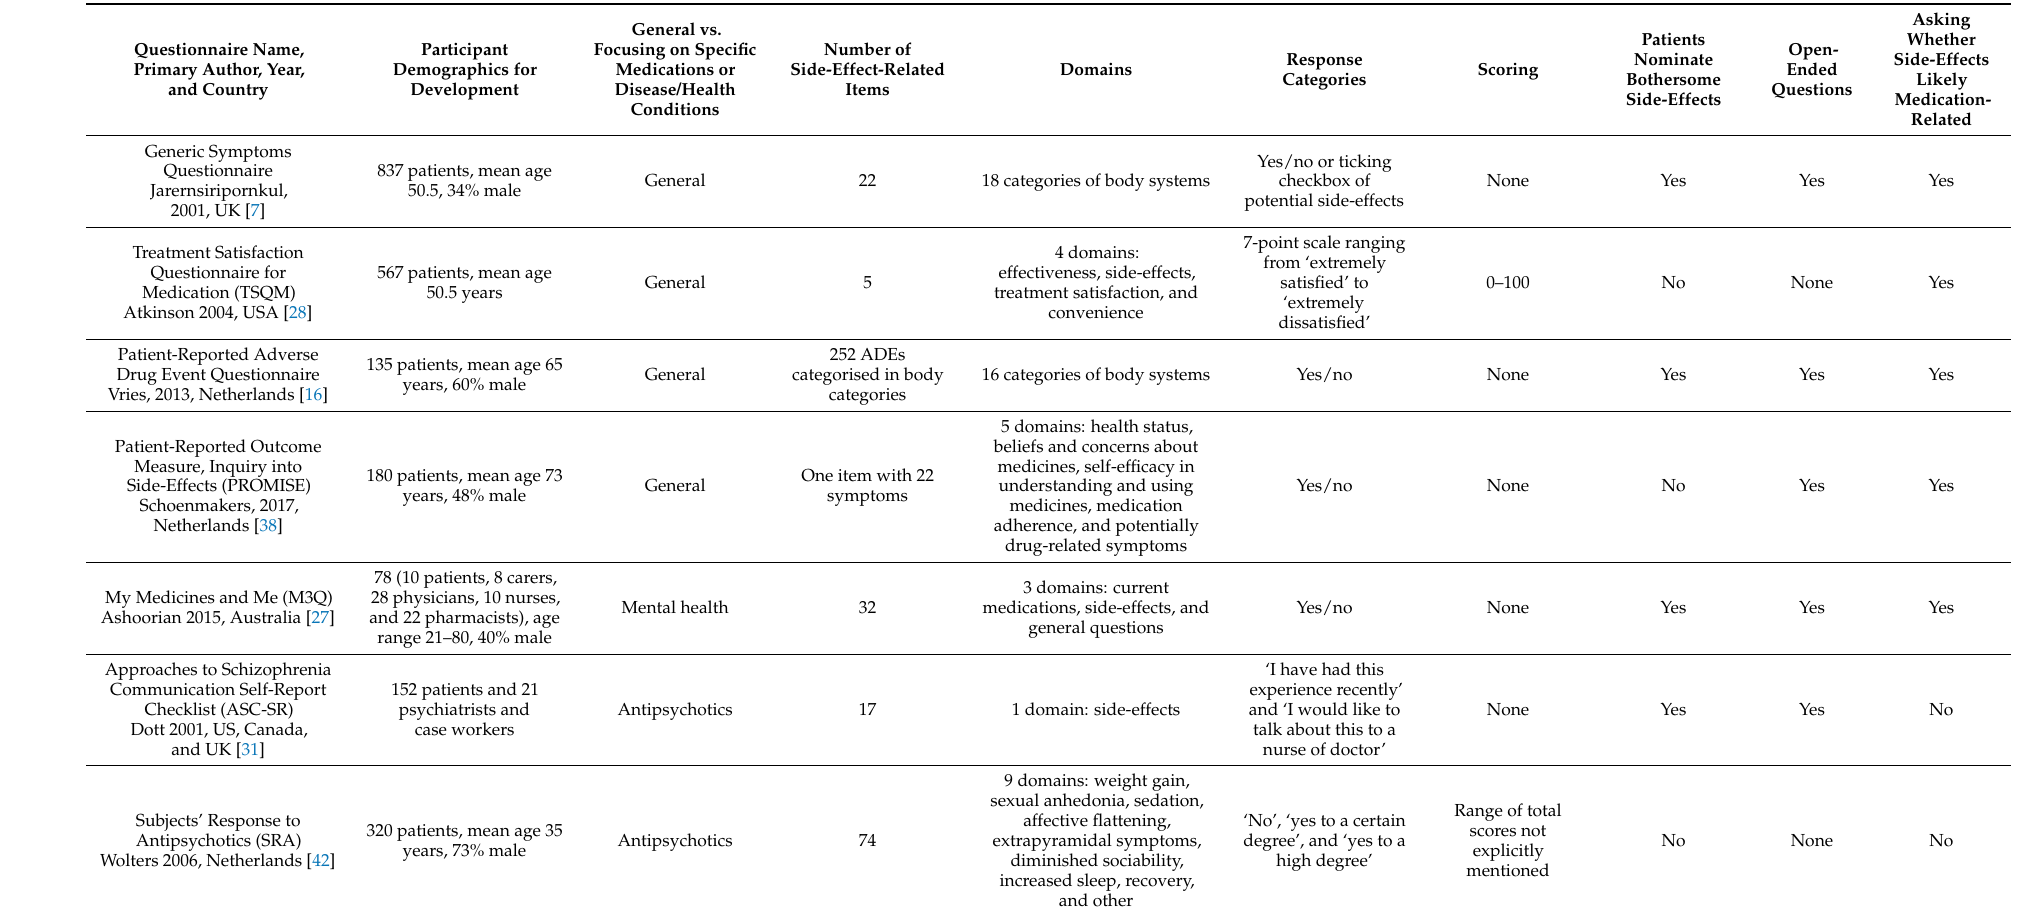
Table 2. Characteristics of patient-reported questionnaires to detect